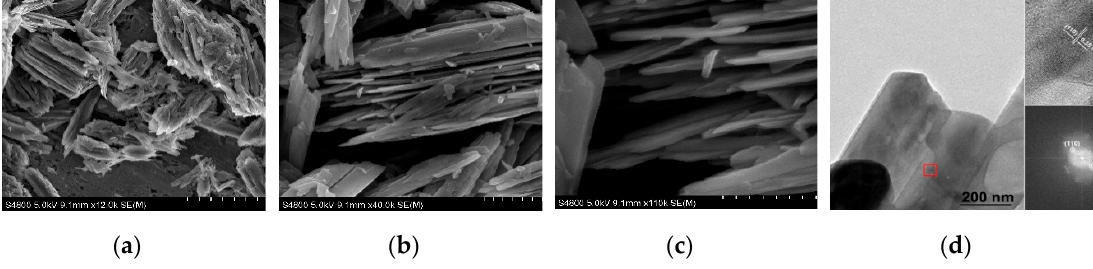
Figure 2. ( a ) Low-, ( b ) medium-, and ( c ) high-magnification SEM images of self-assembled VO 2 (B) nanoflakes synthesized by hydrothermal method. ( d ) TEM image of a single nanoflake. Upper inset: the high-resolution (HR) TEM image for the red square region. Lower inset: the corresponding fast Fourier transform (FFT) pattern.